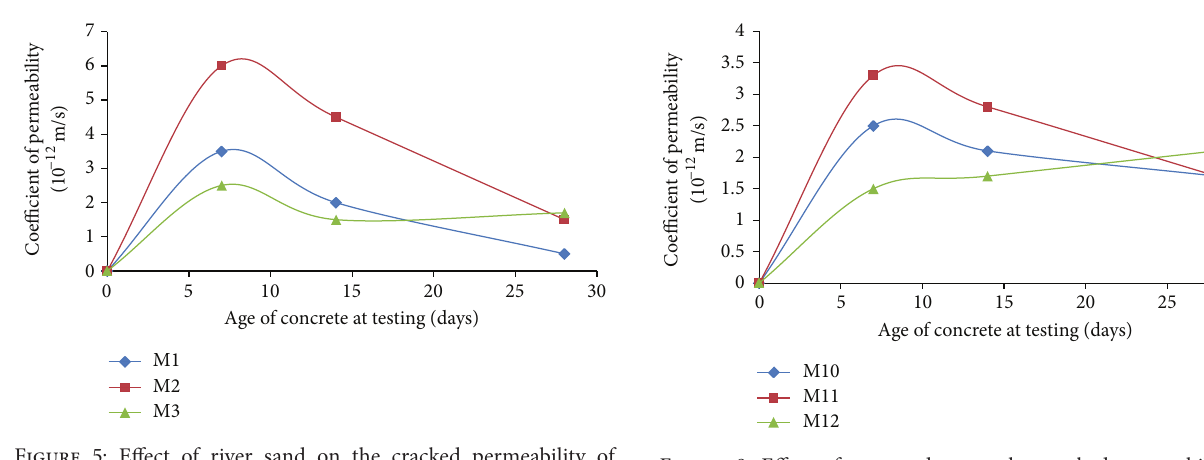
Figure 8: Effect of quarry dust on the cracked permeability of concrete for 350kg/m 3 of cement.